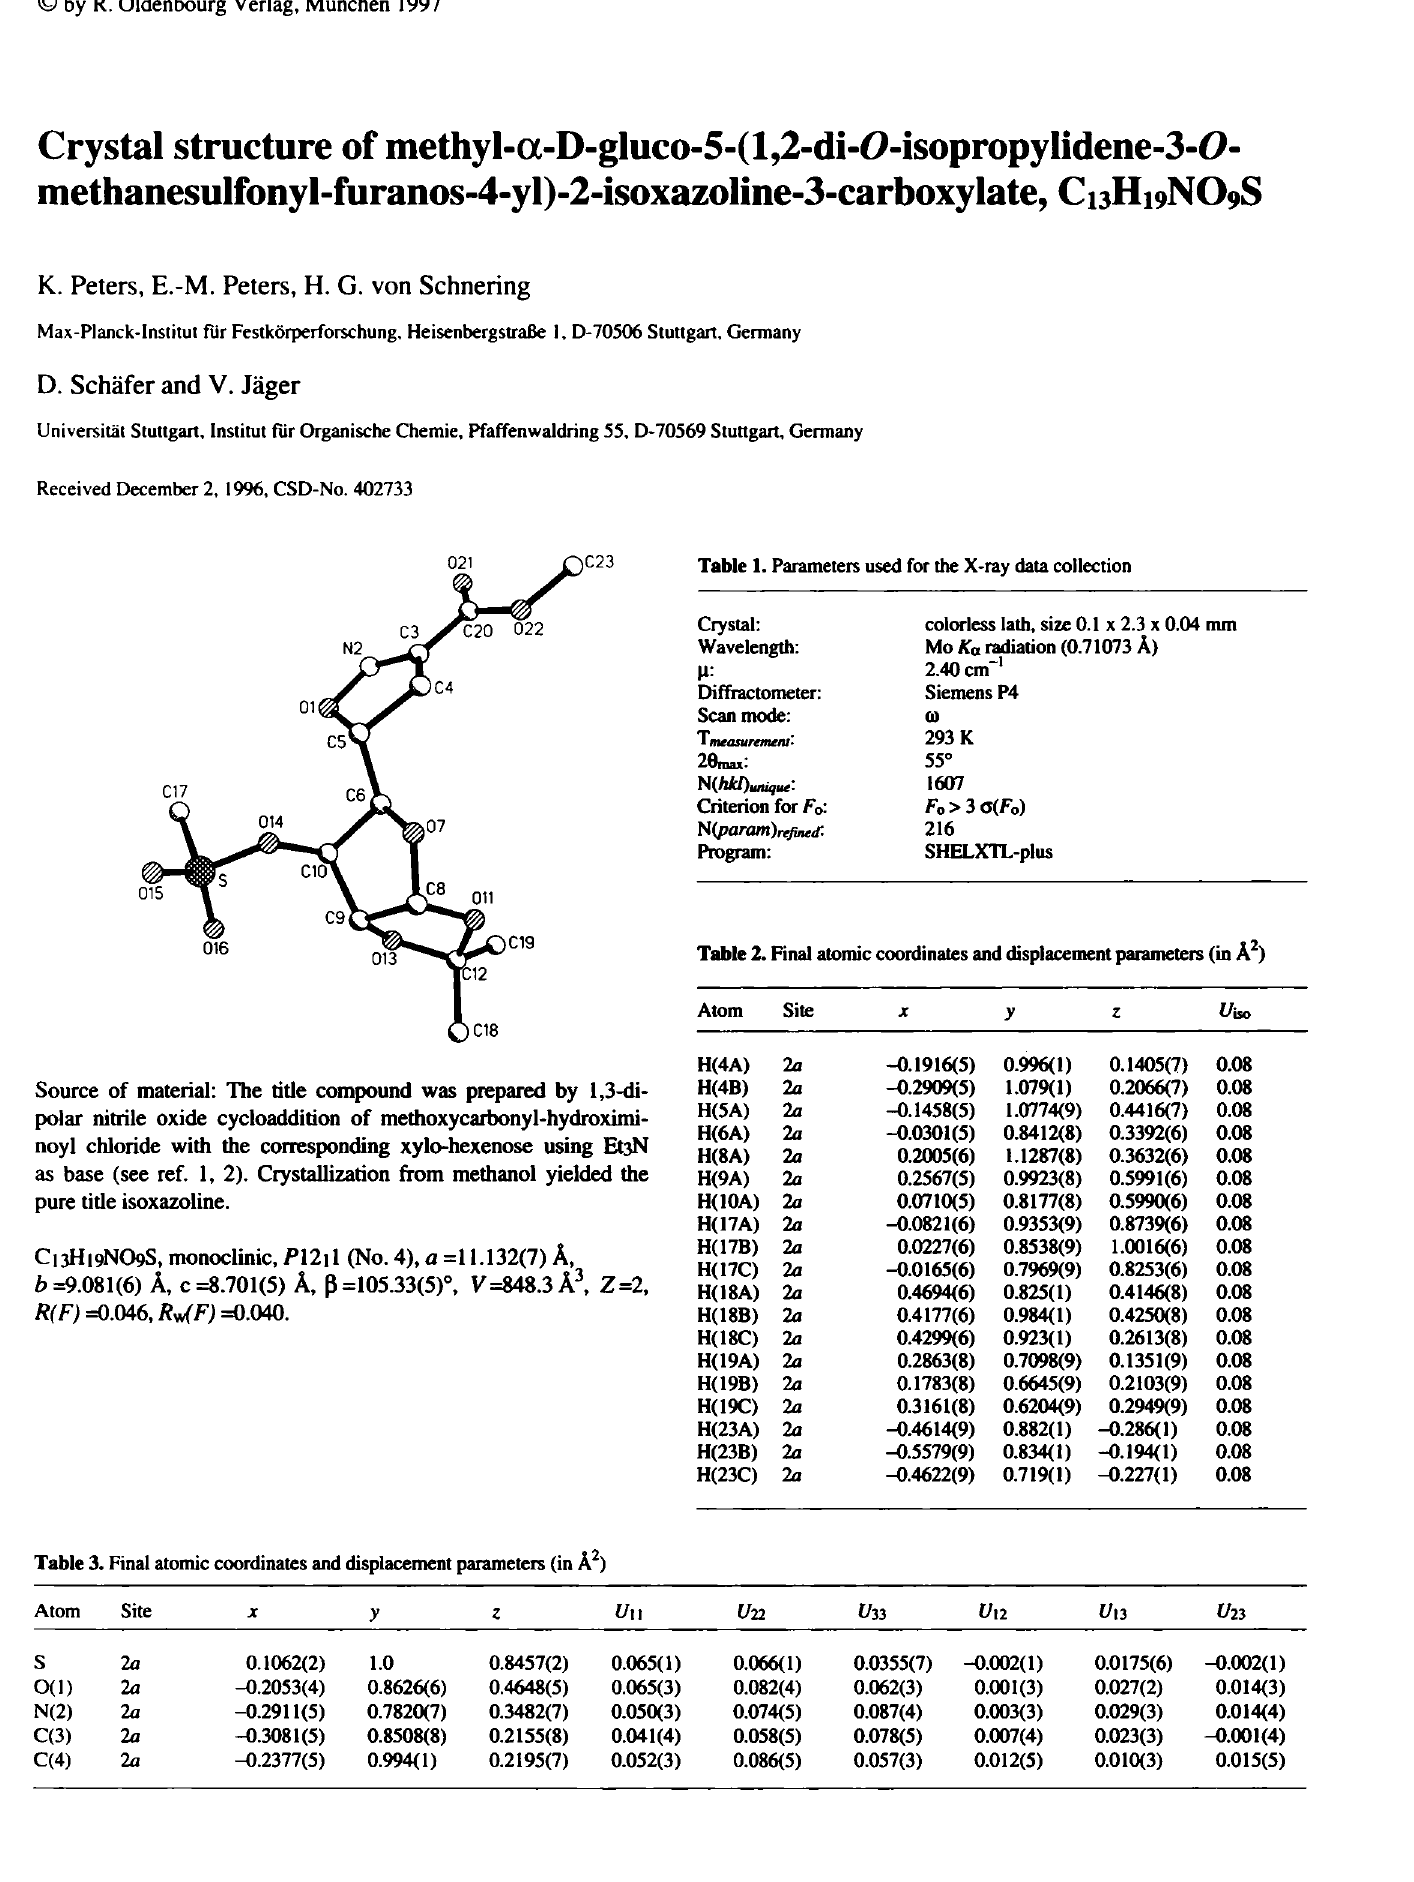
Table 3. Final atomic coordinates and displacement parameters (in Â 2